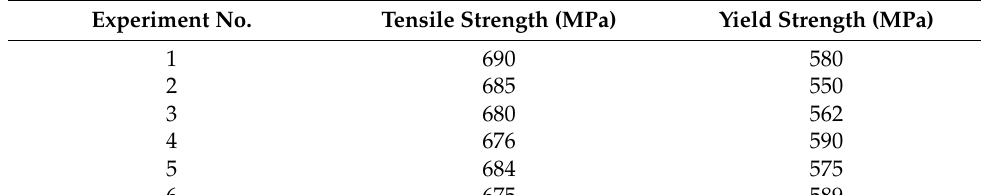
Figure 6. Tensile samples with heat inputs ranging from 1.764 kJ/mm (sample No.1) to 2.33 kJ/mm (sample No.6) after fracture, showing failure in base metal.